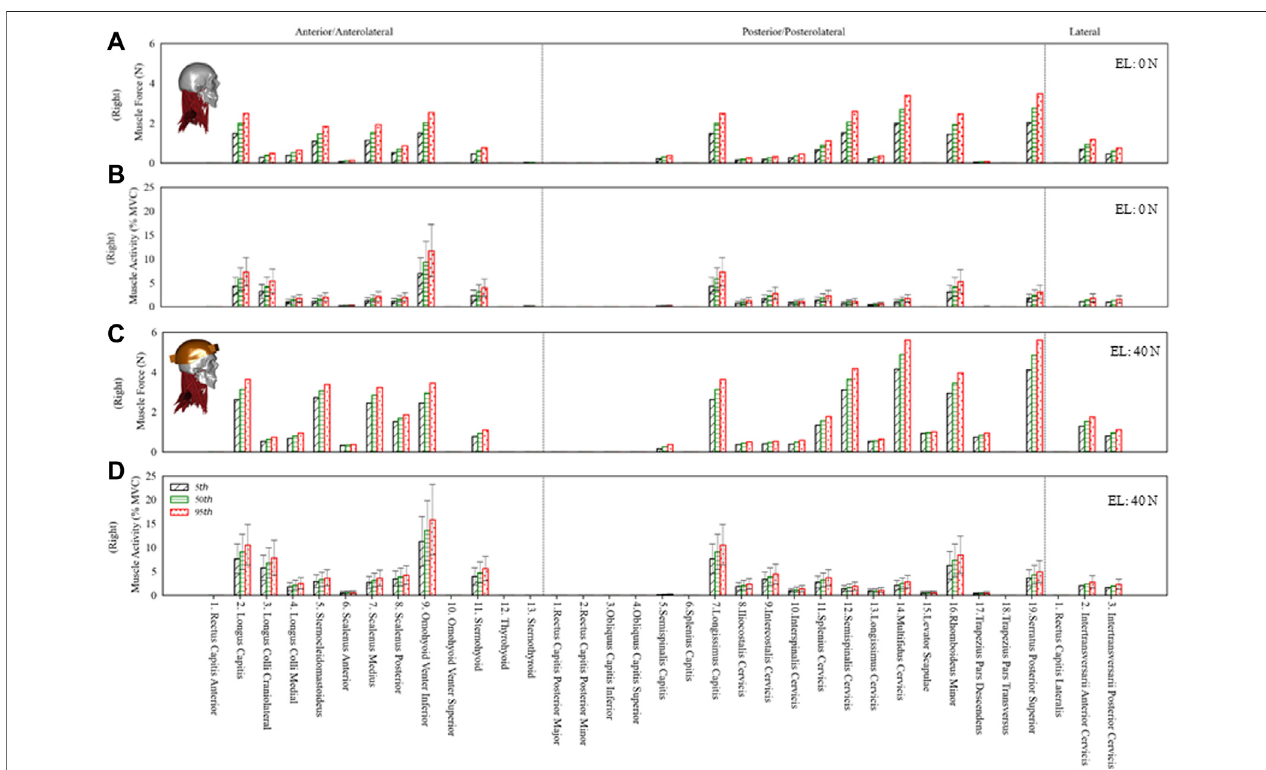
FIGURE 4 | The estimated muscle force and activity of the right side anterior/anterolateral, posterior/posterolateral, and lateral muscle groups for the 5 th , 50 th and 95 th percentile segmental massat 0Nand 40Nexternalload(EL).Error bars showvariationinmuscle activity due todifferences in musclestrength from 30to90 N/cm 2 . (A) Muscle force at 0N EL. (B) Muscle activity at 0N EL. (C) Muscle force at 40N EL. (D) Muscle activity at 40N